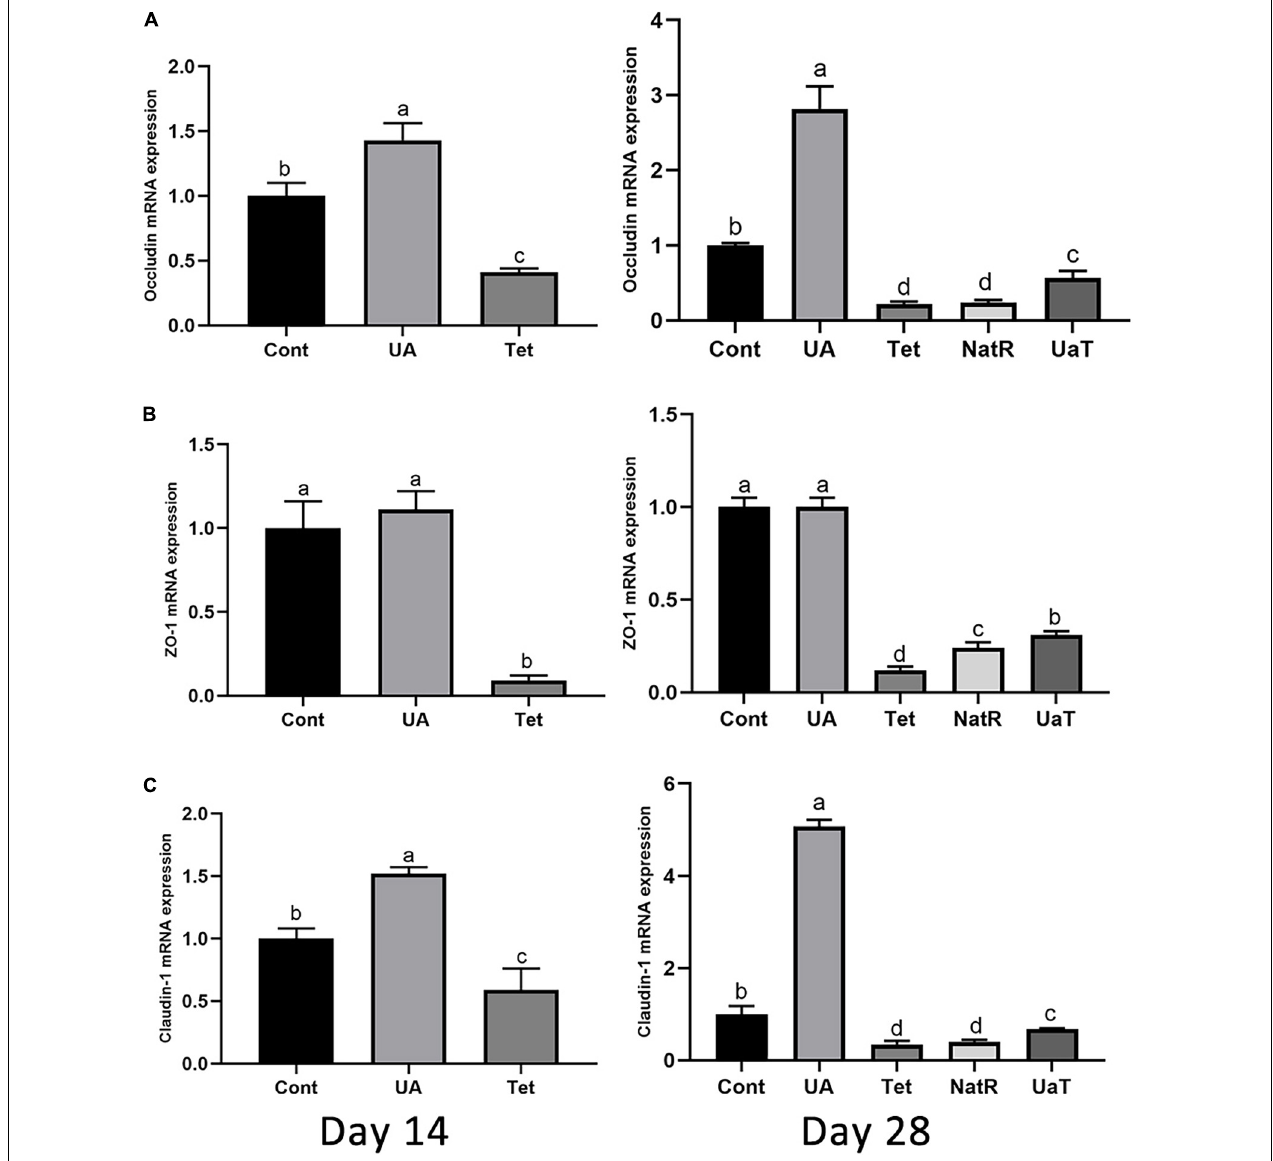
FIGURE 4 | Effects of administration of ursolic acid on the expression of mRNAs corresponding to the tight-junction proteins occludin (A) , ZO-1 (B) , and claudin-1 (C) in jejunum tissue of mice. All group names correspond to those described in the legend of Figure 2 . Data are shown as means ± standard deviations. Statistically significance results between each treatment group on days 14 and 28 were expressed by lowercase letters (a, b, c) based on ANOVA with Duncan’s range tests. Mean values with different letters indicate statistically significance results ( P < 0.05). n = 6 mice per group.